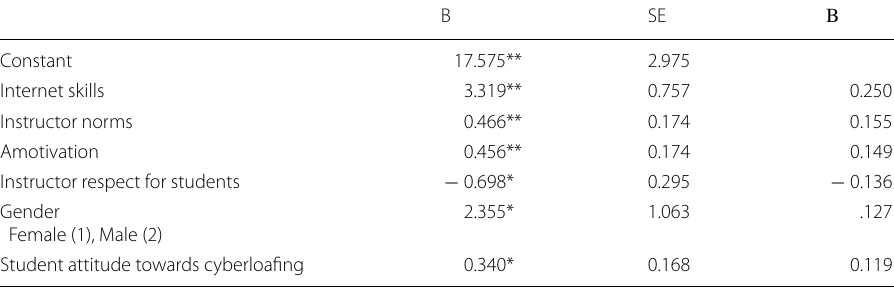
N 272, R 2 17.9%, Adjusted R 2 = = *p < 0.05, ** p <